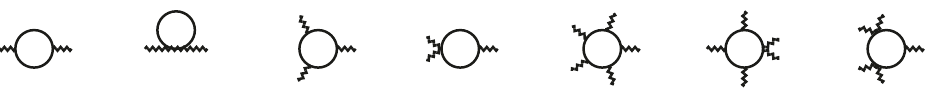
Figure 7 . 1-loop contributions to the MQCD 2-point, 3-point and 5-point functions in the back- ground field gauge. Wiggly lines denote ultrasoft gluons and solid lines adjoint